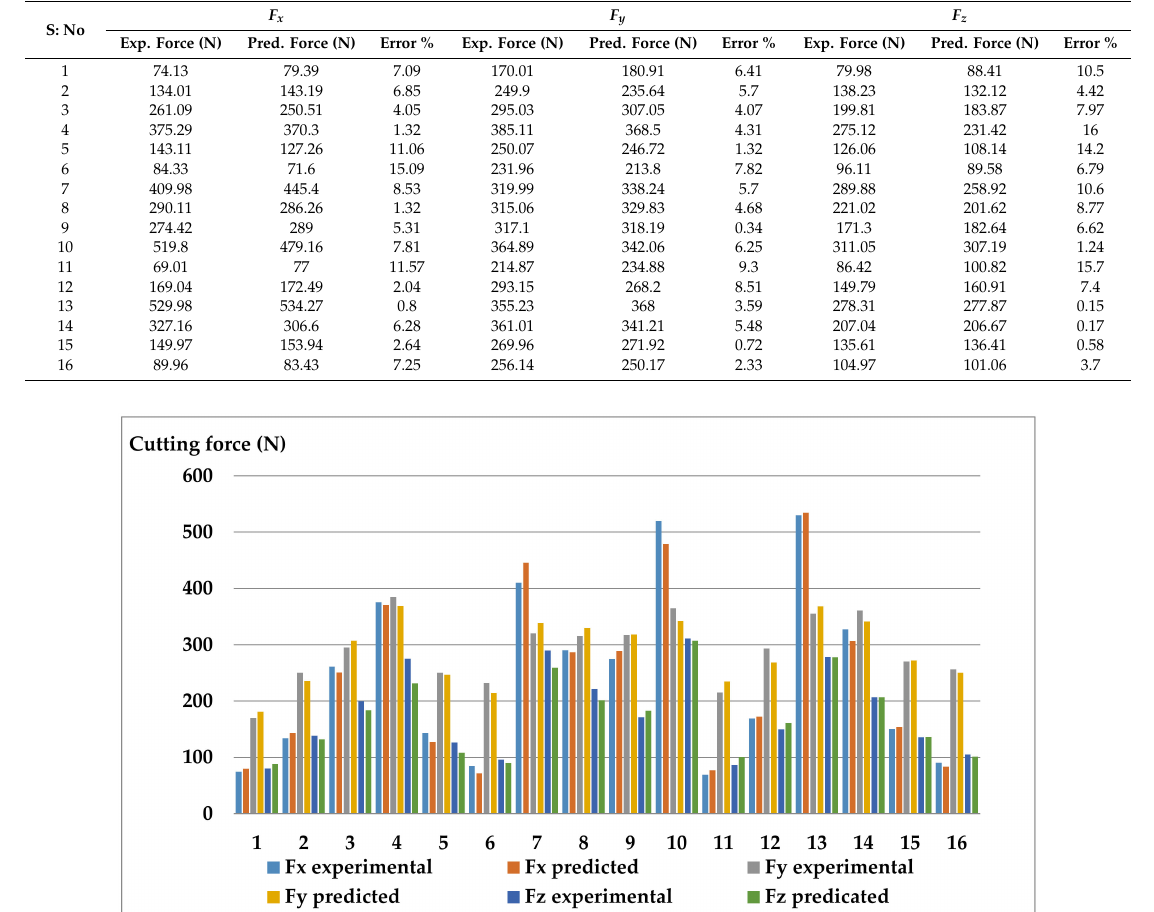
Figure 13. Cutting force comparisons between experimental and RSM predicted values of F x , F y , F z .